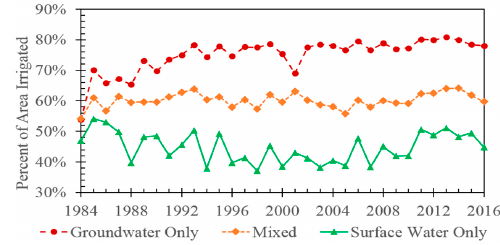
Figure 5. Time series of proportion of place of use for each water right that was irrigated. Results are reported separately for land irrigated with groundwater only, surface water only, or a mix of surface and groundwater sources.